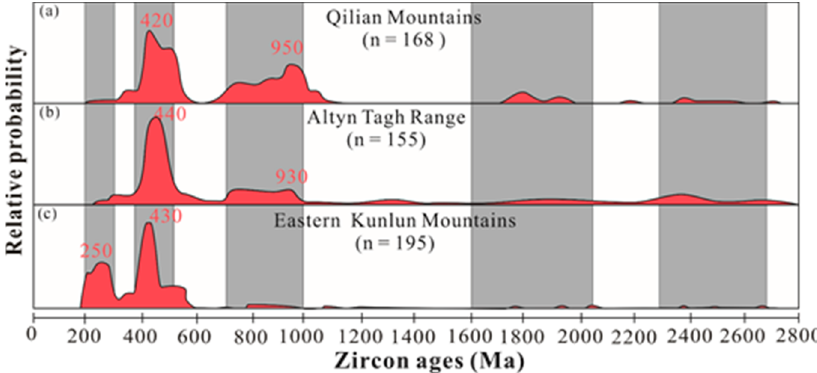
Figure 2. The relative probability plots of zircon U–Pb ages [9] from ( a ) basement rocks in the Qilian Mountains, ( b ) basement rocks in the Altyn Tagh Range and ( c ) basement rocks in the Eastern Kunlun.